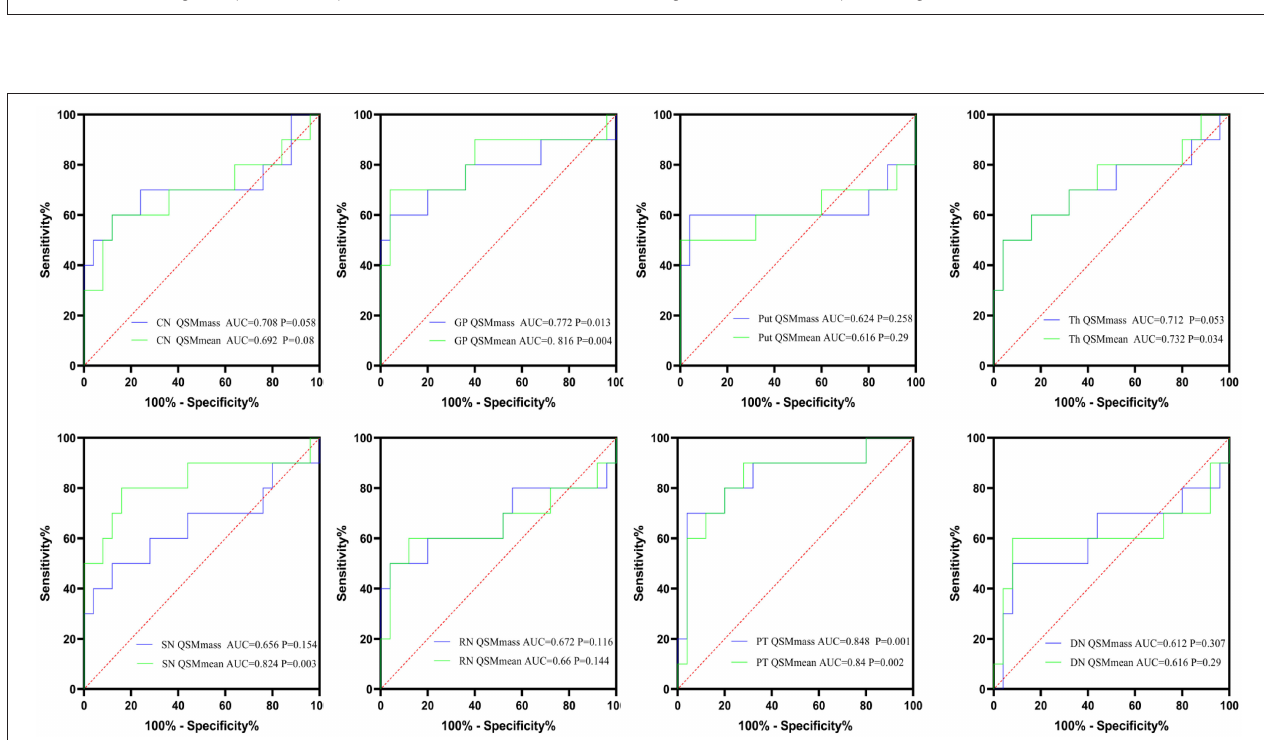
FIGURE 7 | The results of ROC curve analyses of mean bulk susceptibility and total susceptibility between hep-WD and HCs. CN, head of the caudate nucleus; DN, dentate nucleus; GP, globus pallidus; Put, putamen; RN, red nucleus; SN, substantia nigra; Th, thalamus; PT, pontine tegmentum.